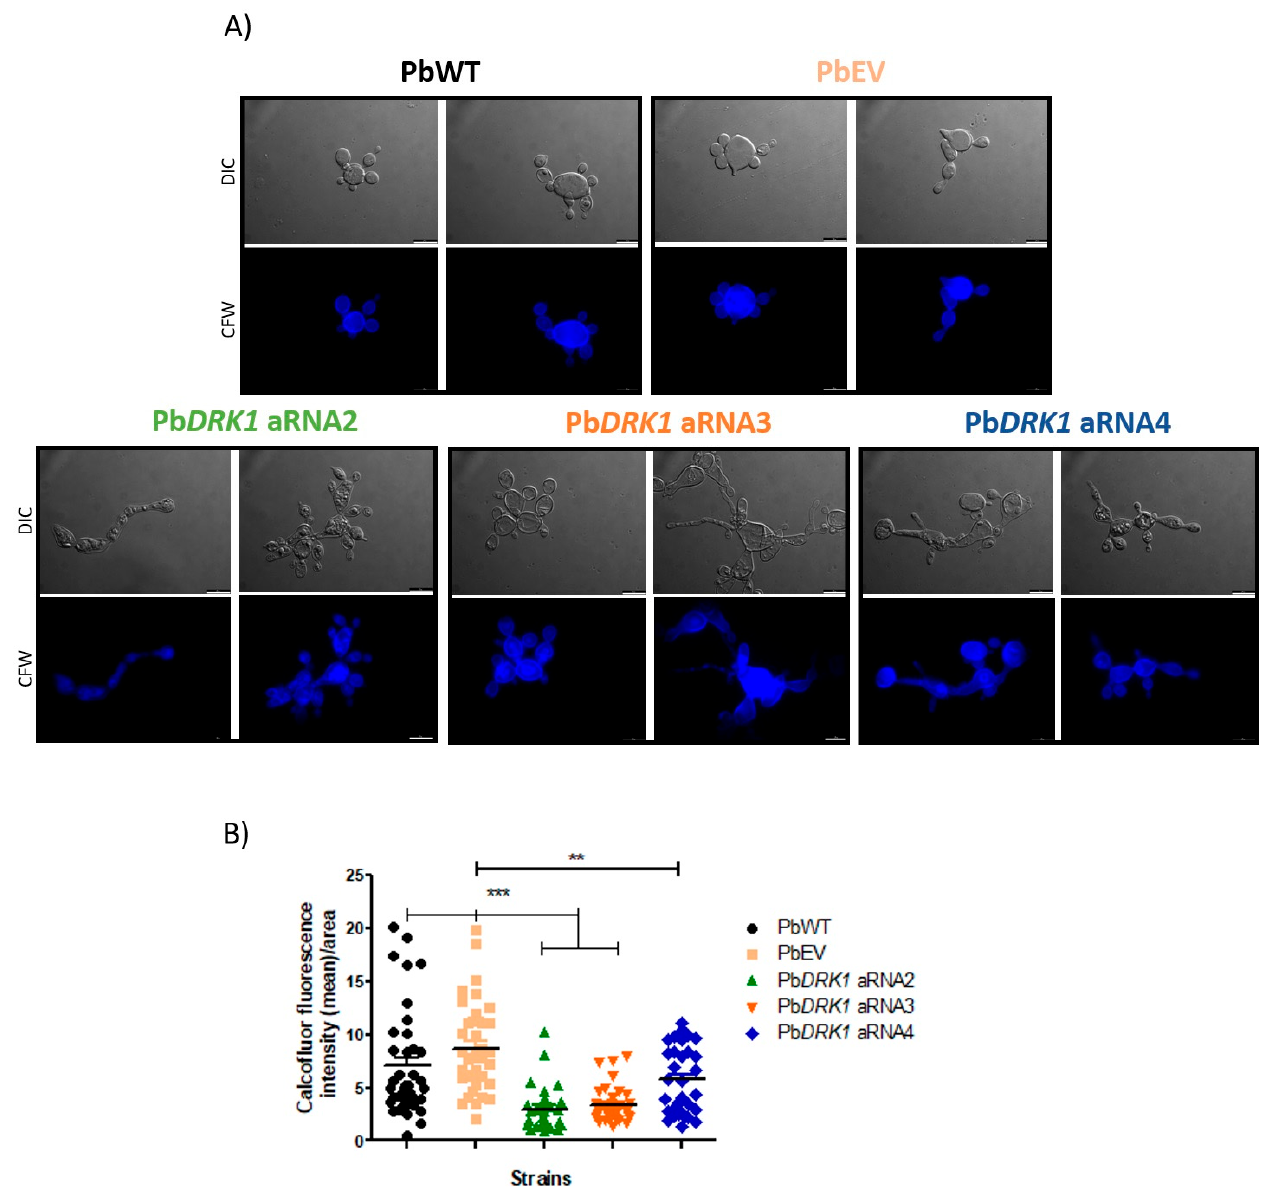
Figure 9. The level of DRK1 expression reduction correlates with a greater reduction of chitin in P. brasiliensis . Yeast cells of PbWT, PbEV, and PbDRK1 aRNA strains grown for 72 h at 37 ◦ C in BHI medium (1% glucose) (150 rpm). Paraformaldehyde- fixed cells were stained with calcofluor white (50 µ g mL − 1 ) for 1 h at RT, and after several washes with PBS were ( A ) visualized under fluorescence microscopy, DMi8 (Leica) and images processed with LasAF software. Scale bars: 10 µ m. ( B ) The chitin amount was estimated by measuring the calcofluor fluorescence intensity (mean)/area of each cell using ImageJ software. *** p < 0.0001 and ** p < 0.001.